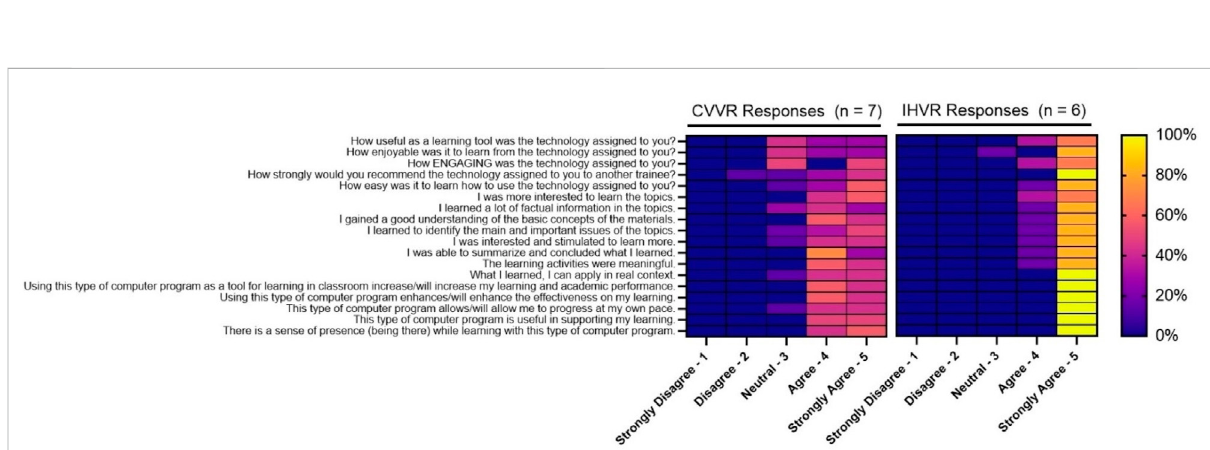
FIGURE 2 Representative self-reported evaluation of virtual reality technology. The heat map shows the percentage of trainees in each group, CVVR and IHVR, responding to each question ( x -axis) to options in the Likert scale ( y -axis). Yellow represents 100% response and blue box represents 0%